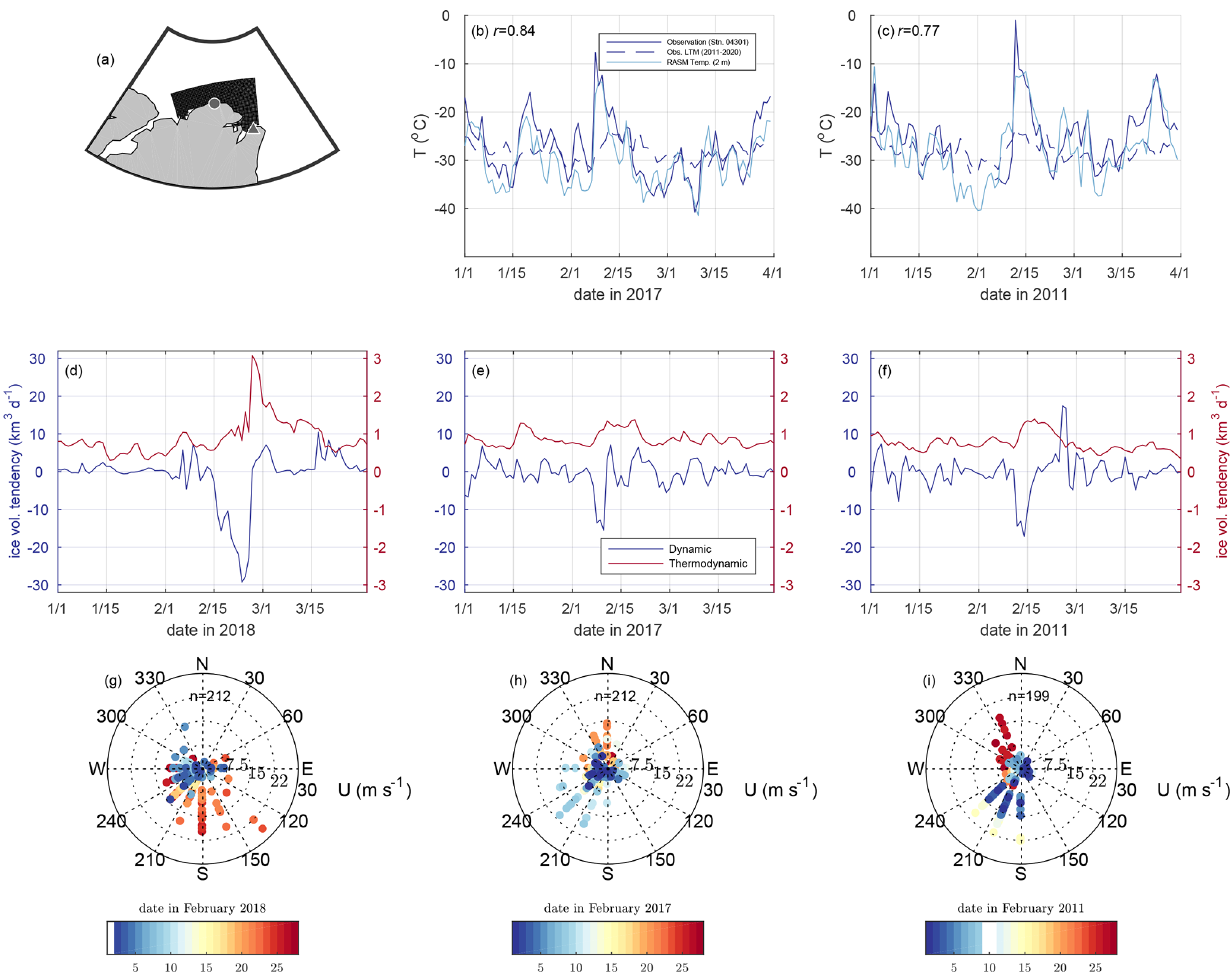
Figure 4. The observed daily near-surface air temperature ( T ; ◦ C) (blue) from Station 04301 (Cape Morris Jesup as • ) in (a) and the RASM daily 2m air temperature (light blue) from the nearest grid cell during January–March of (b) 2017 and (c) 2011; the observed long-term (2011–2020) daily mean (LTM) (blue-dashed). The correlation coefficient ( r ) between the observed and the simulated air temperature is shown in the upper left of (b) and (c) . The time rate of change in the RASM daily sea ice volume (km 3 d − 1 ) due to thermodynamic (red) and dynamic (blue) tendency during January–March of (d) 2018, (e) 2017, and (f) 2011, spatially integrated for the black-shaded area in (a) . The wind rose plots of 3h wind data at Station 04312 (Station Nord as (cid:78) ) during February of (g) 2018, (h) 2017, and (i) 2011: wind speed ( U ;ms − 1 ) and direction. The missing data are indicated as white in each color